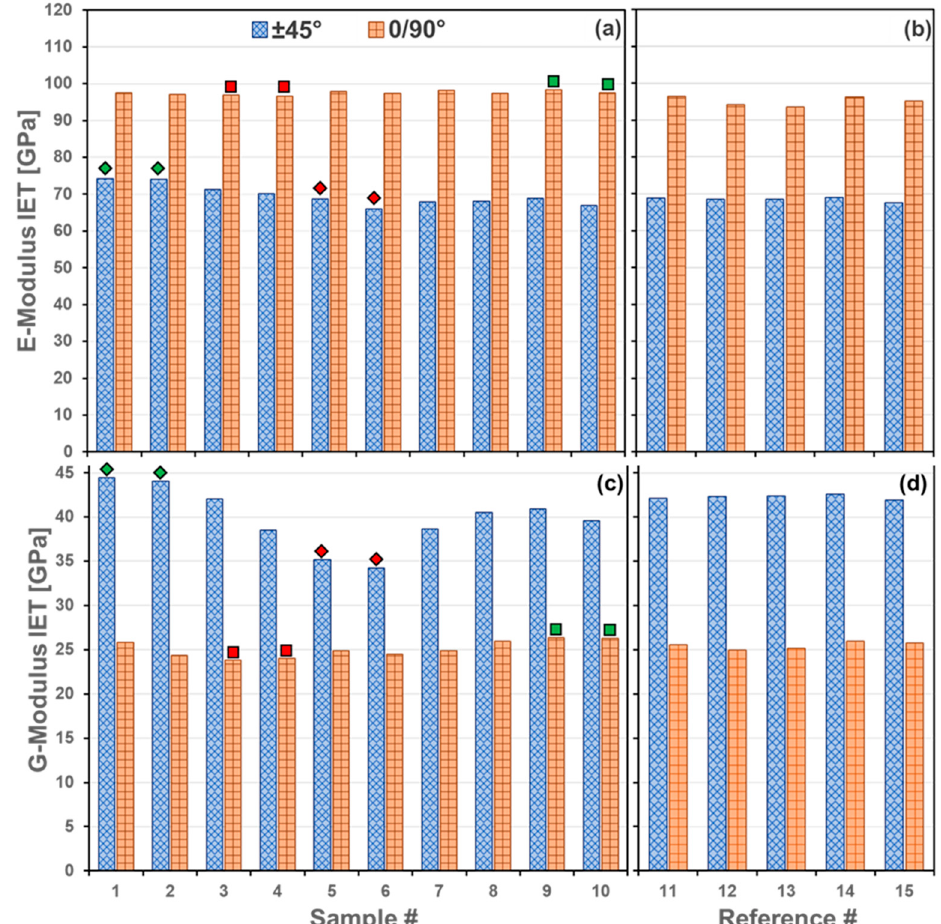
Figure 3. Young’s and shear modulus of bending bars determined using the impulse excitation technique. Marked samples were selected for further examination in XCT and SEM. ( a , c ) Samples from inhomogeneous areas of the C-scan. ( b , d ) Reference samples from homogeneous areas of the C-scan. Table 1. Summary of experimental properties determined using impulse excitation technique and three-point bending test.